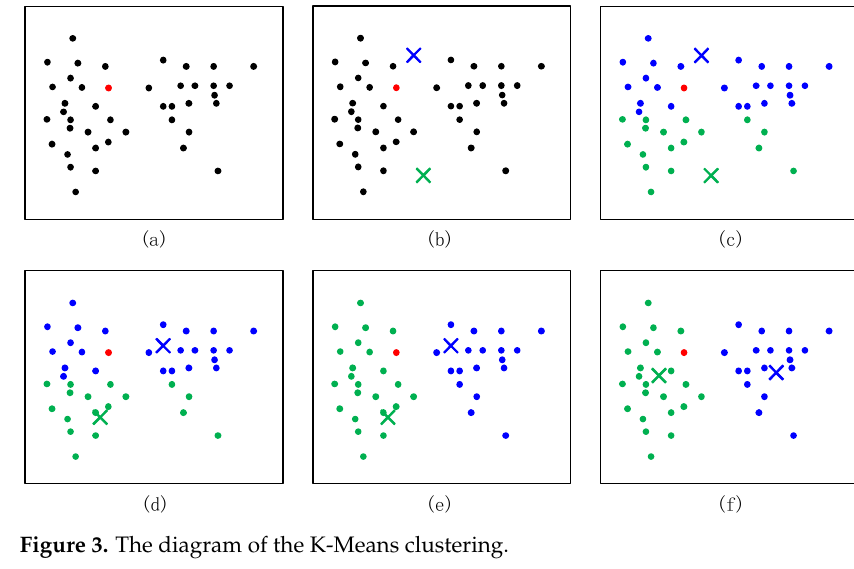
Algorithm 1: Coordinate Clustering based on K-Means